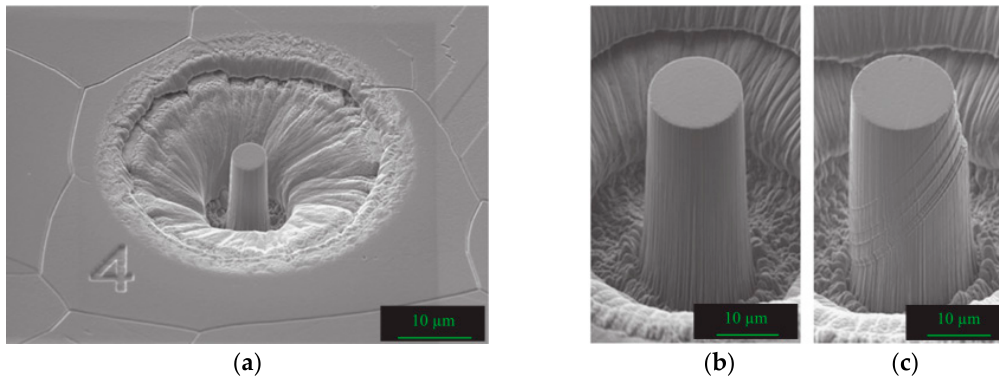
Figure 2. Example of ( a ) 5 µm and ( b ) 15 µm pillars cut within large grains, and ( c ) deformed large pillar after compression testing, reproduced from [11], with permission from Elsevier, 2013.